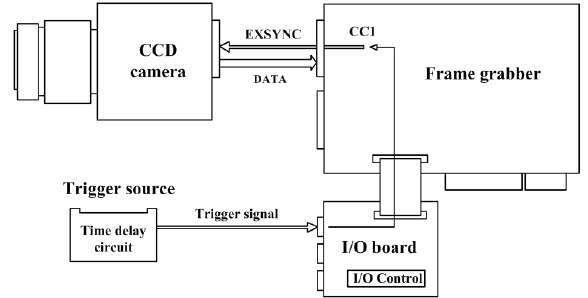
Figure 3. Trigger delay visualization from the trigger source to the camera.